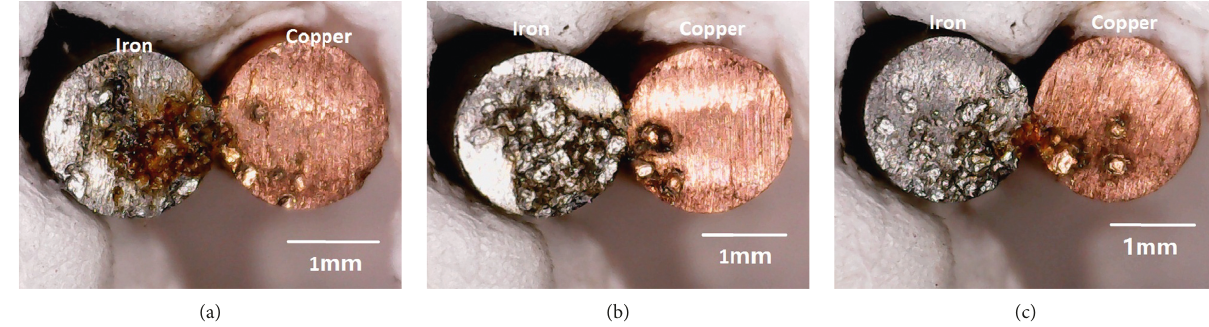
Figure 3: Discharge point distribution on the surface of iron and copper electrodes.